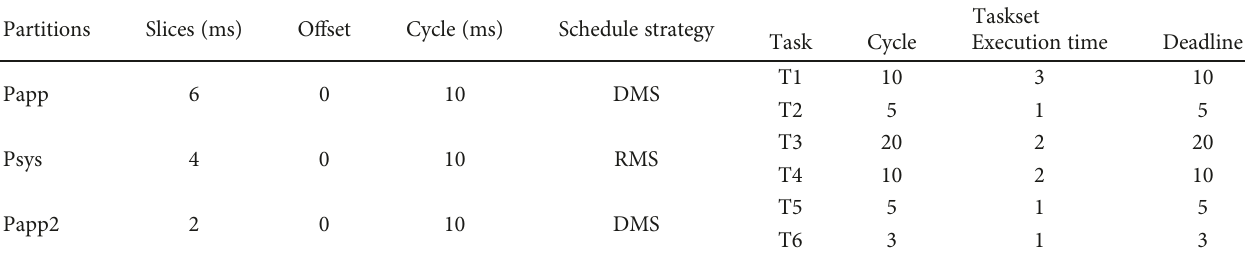
Table 16: Reschedule information of WAW system (time unit: